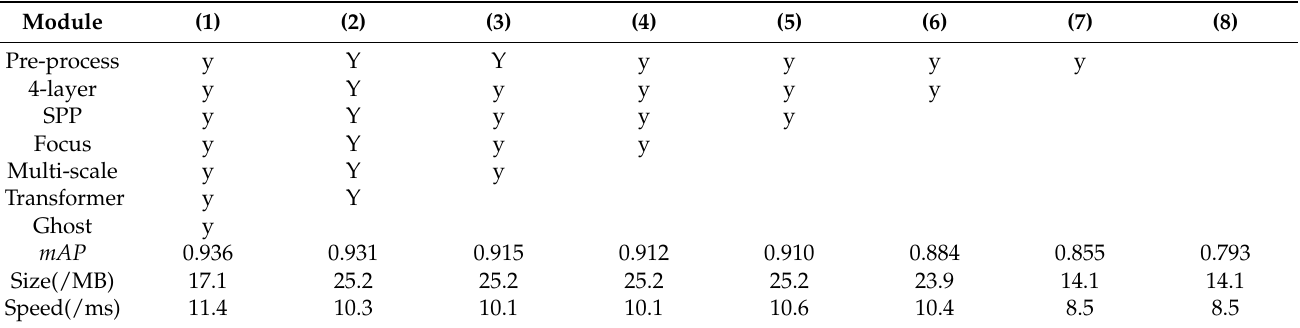
Table 4. Ablation experiments of the proposed